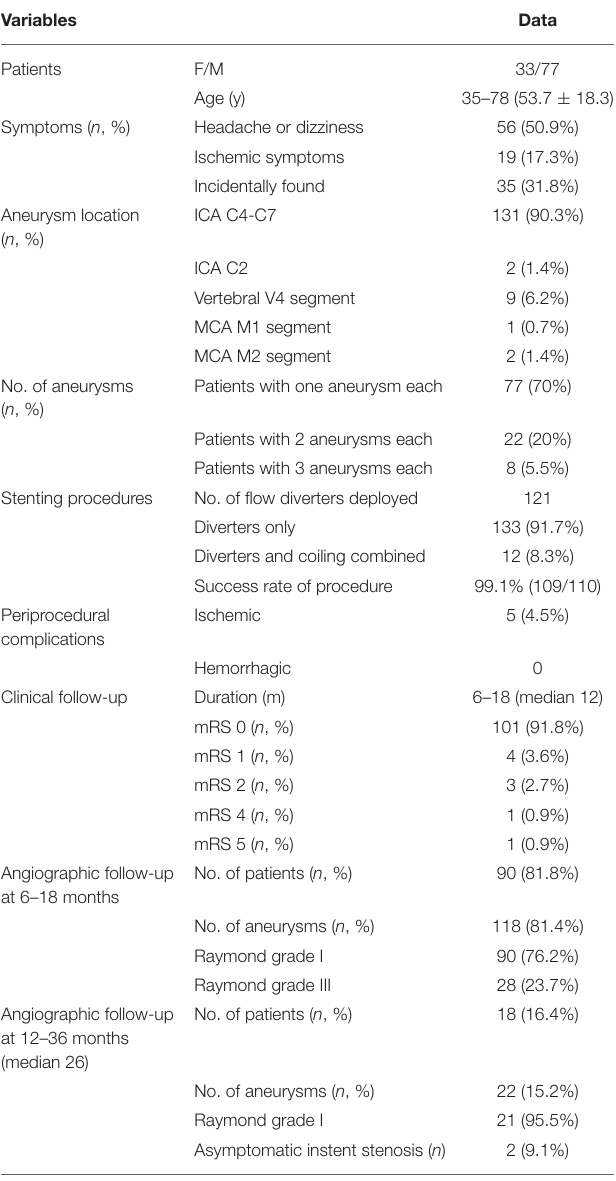
TABLE 1 | Demography, clinical data, and endovascular treatment. Variables